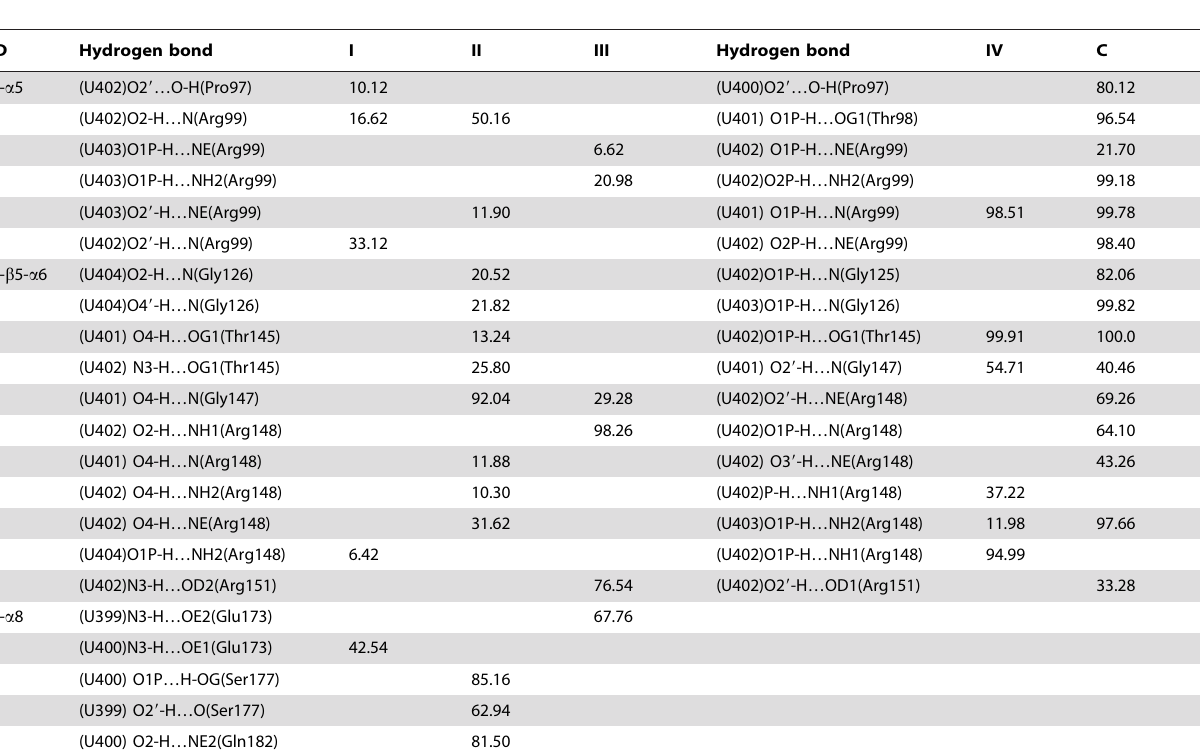
Table 3. The occupancies (%) of hydrogen bonds between the RNA molecule and the N-domain (ND) of the eIF4A protein for the I, II, III, IV and ATP + RNA + C-eIF4A (C) models.